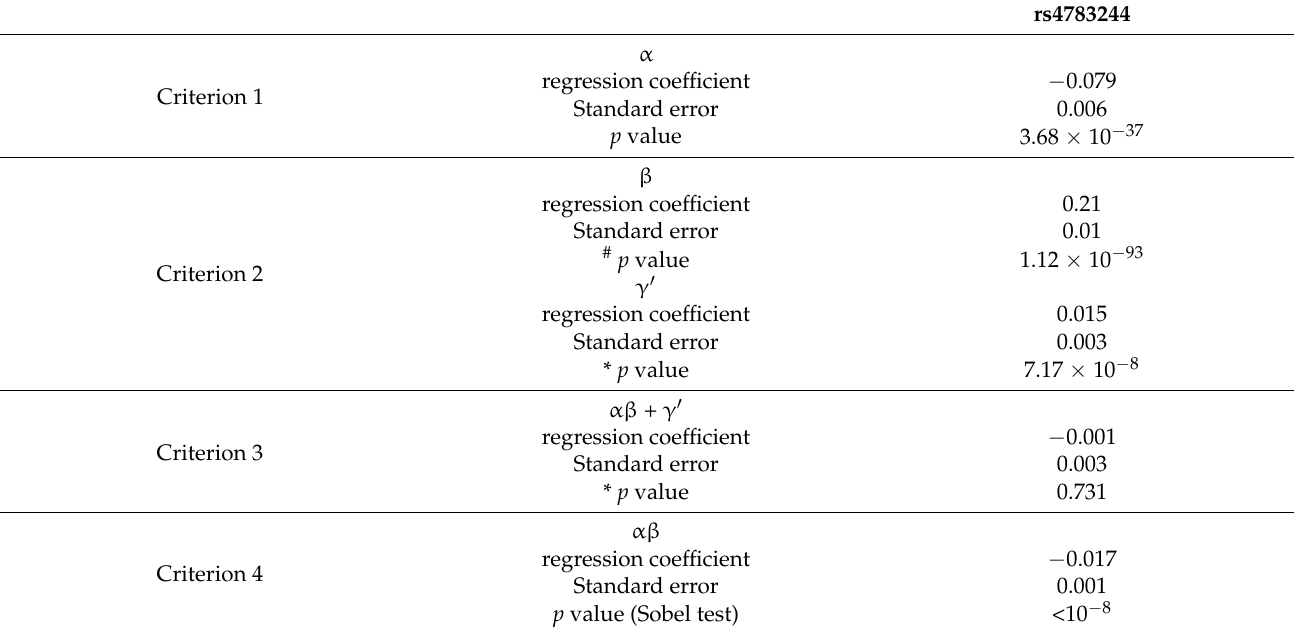
Table 3. Mediation analysis of adiponectin levels on the association between CDH13 SNP rs4783244 and HDL-C